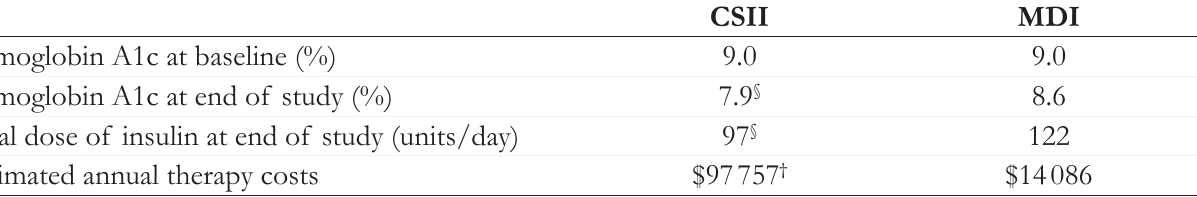
Table 2. Hemoglobin A1c at Baseline and End of the Opt2mise Study (6 Months), Daily Insulin Dose at End of the Opt2mise Study, 11 along with Estimated Annual Therapy Costs for Insulin, Needles and